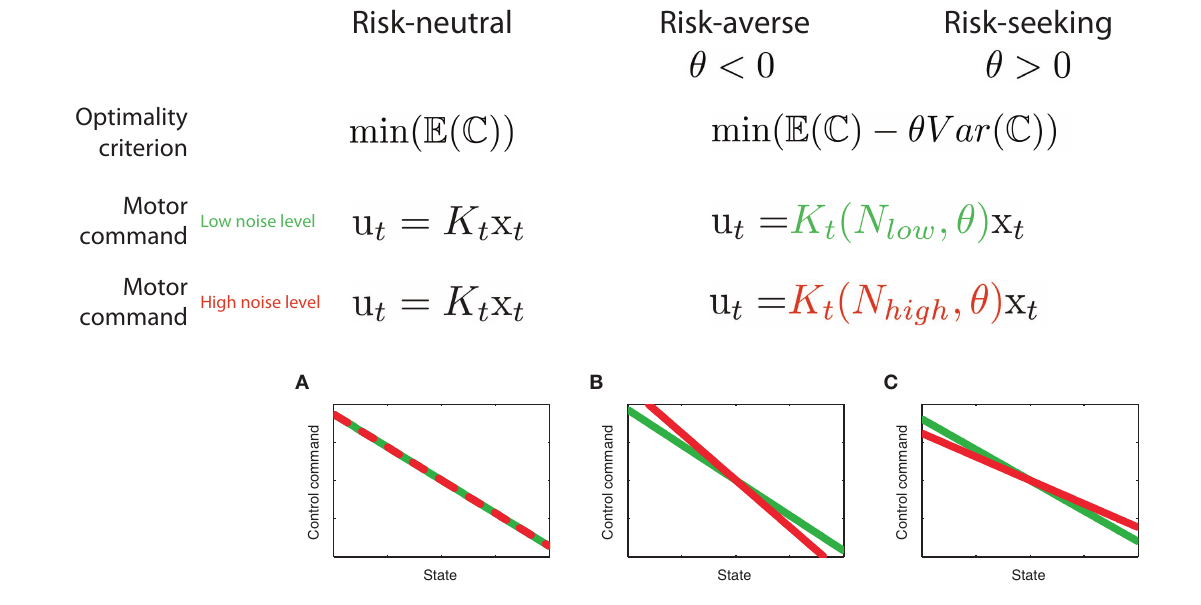
depending on its risk-attitude θ . (A–C) Changes in motor command with the state for a low noise level (green) and for a high noise level (red) for the risk-neutral (A) , risk-averse (B) and risk-seeking (C) controllers. In our experiments the state is given by the positional deviation of a cursor from the center of a target line (the cursor can deviate to the left or to the right leading to positive or negative State) and the control task is to reduce this deviation